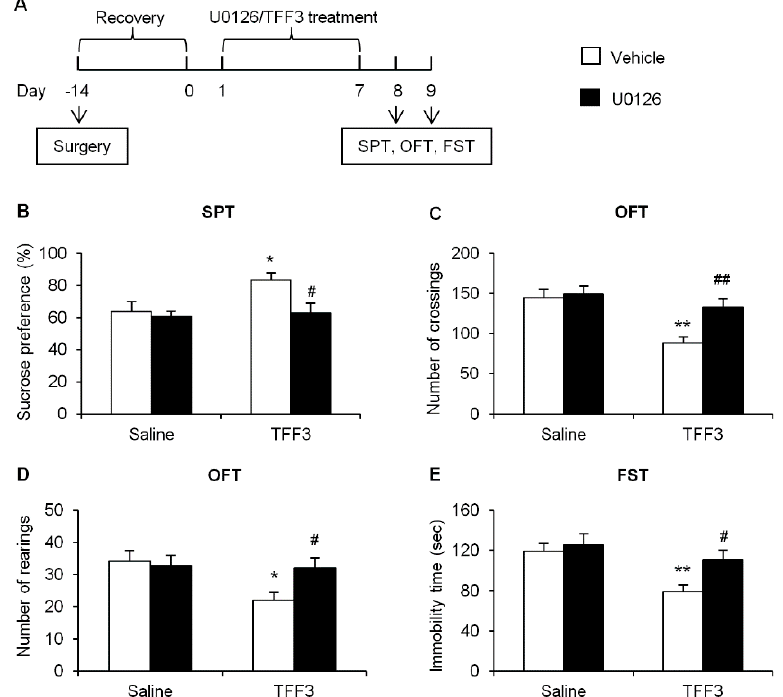
Figure 6. Inhibition of pERK in CA3 blocked the antidepressant-like effects of TFF3 in OB rats. ( A ) Timeline of the experimental procedures. Sucrose preference ( B ) in the sucrose preference test (SPT), crossings ( C ) and rearings ( D ) in the open field test (OFT), and immobility time in the forced swim test (FST) ( E ) were measured after 7-day drug treatment. U0126 blocked the antidepressant-like effects of TFF3 in OB rats. The data are expressed as mean ± SEM ( n = 7–8 per group). * p < 0.05, ** p < 0.01, compared with saline-vehicle group; # p < 0.05, ## p < 0.01, compared with TFF3-vehicle group. In SPT, with TFF3 (saline and TFF3) and U0126 (vehicle and U0126) as between-subjects factors, the two-way ANOVA revealed the significant effects of TFF3 ( F (1,27) = 4.28, p < 0.05) and U0126 ( F (1,27) = 4.81, p < 0.05), but no significant TFF3 × U0126 interaction ( F (1,27) = 2.64, p > 0.05, Figure 6B). In